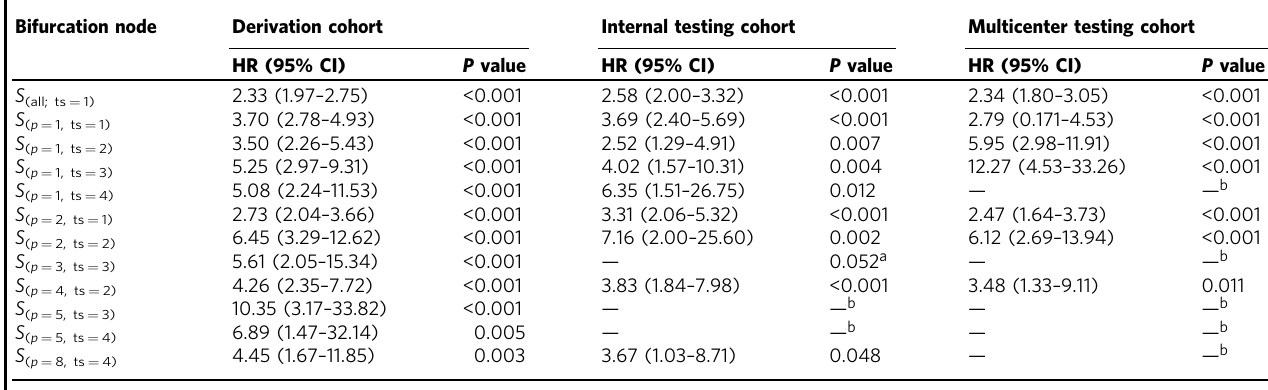
Table 4 Hazard ratio and signi fi cance of upper node versus lower node at each path bifurcation in the derivation, internal testing, and multicenter testing cohorts